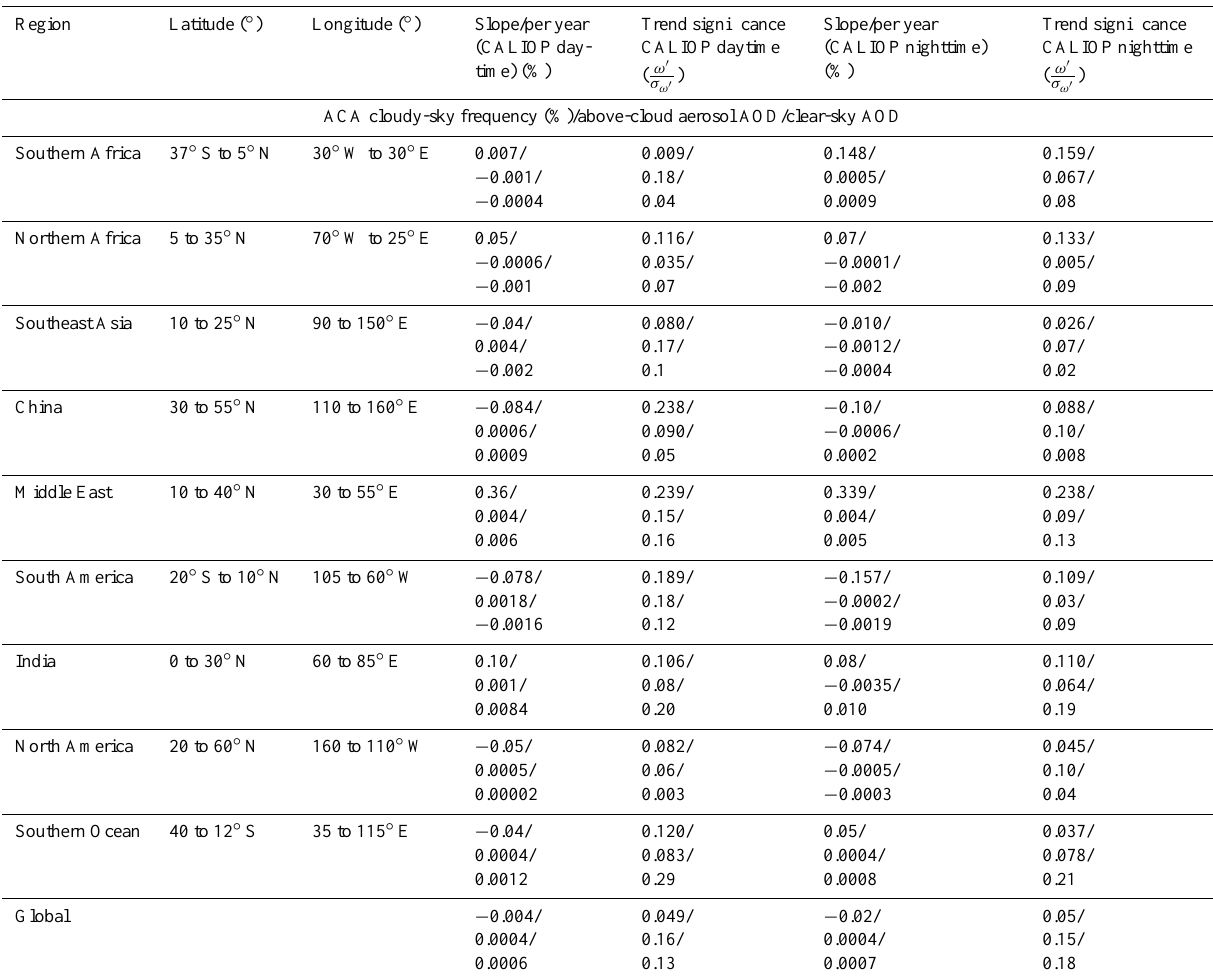
Table 3. Seven-and-a-half-year above-cloud aerosol cloudy-sky frequency, ACAOD, and clear-sky AOD interannual variability analysis for the selected target regions. Aerosol and cloud layers retrieved with “intermediate” or “strict” QA metrics are considered in this analysis. Yearly variation for the entire globe is also included. For each region, interannual variability (frequency change per year) for the three parameters – the ACA cloudy-sky frequency, ACAOD, and clear-sky AOD values – is reported. Note that the interannual variability for clear-sky AODs is estimated using 100% cloud-free data from the CALIOP cloud and aerosol layer products.